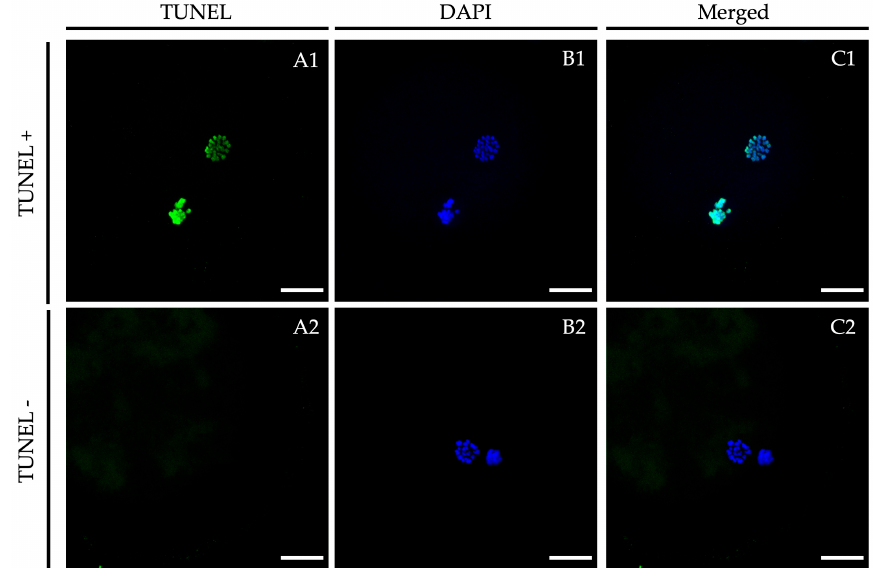
Figure 3. Representative TUNEL assay images vitrified / warmed oocytes after in vitro maturation in the presence of LIF. Oocytes were stained by TUNEL to detect apoptosis (( A1 , A2 ); green signal) and nuclei were counterstained with DAPI (( B1 , B2 ); blue